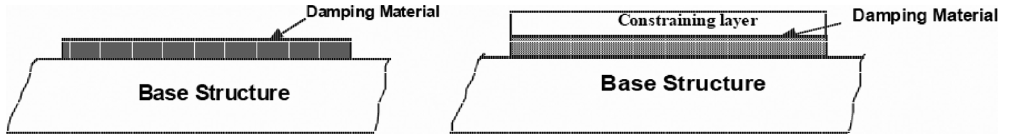
Fig. 2. Surface treatments: Free layer (left), Constraint layer (right)